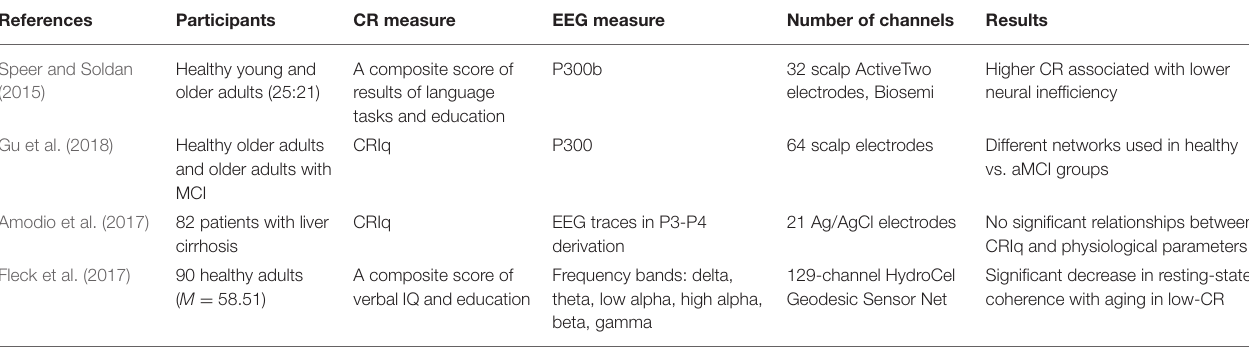
TABLE 1 | Results after qualitative